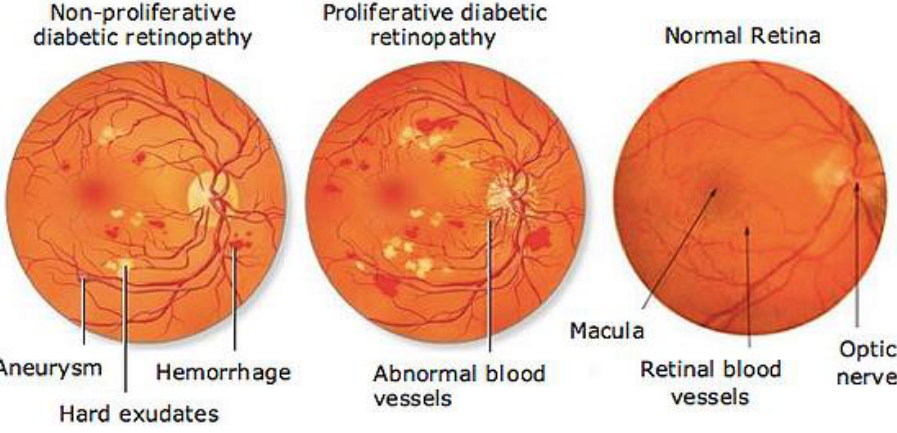
Figure 1. Fundus images.